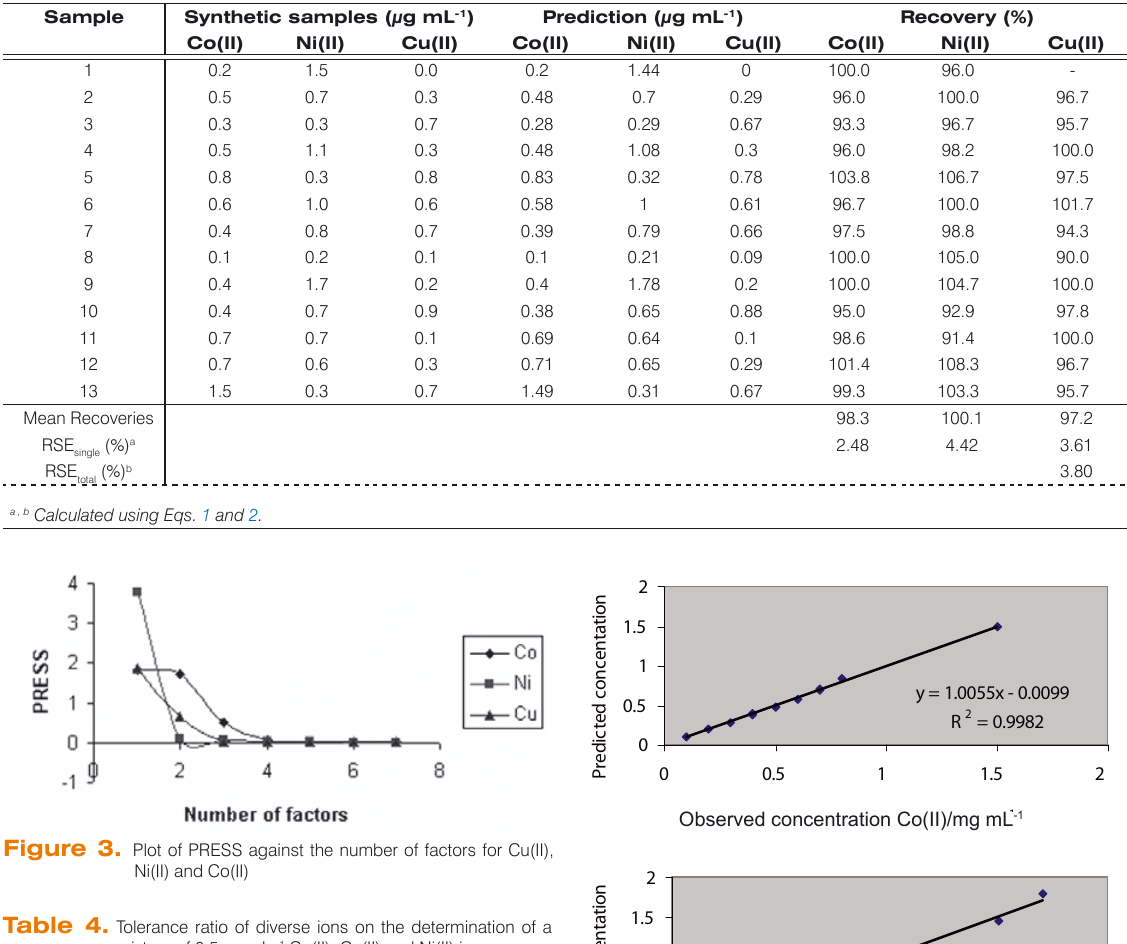
Table 3. Composition of prediction data set (randomly designed), validation by the PLS model and statistical parameters for the system Sample